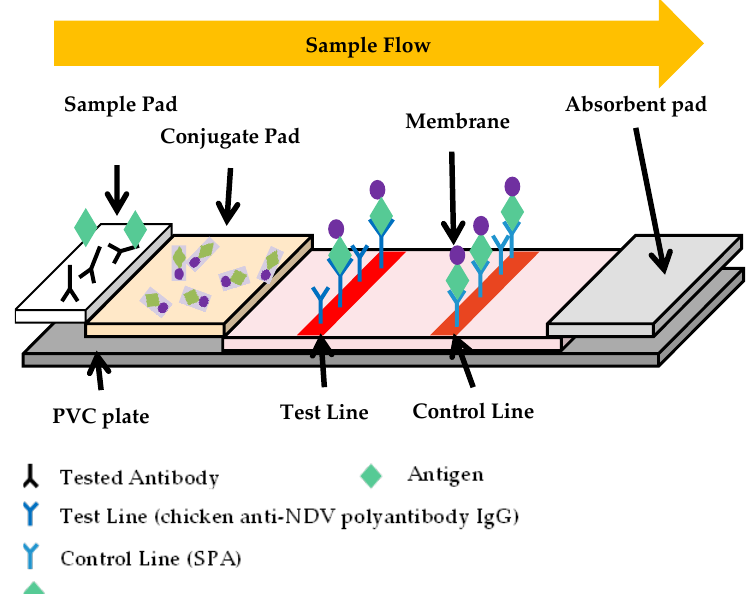
Figure 1. The schematic representation of the bLFA strip. The bLFA strip included three pads (sample, conjugate, and absorbent), a nitrocellulose (NC) membrane, and a PVC plate. The conjugate pad contained the dried gold-labeled mAb, which provided an easily visible red color. There were two blots of chicken anti-NDV polyantibody IgG and SPA for the T- and C-lines on the NC membrane,